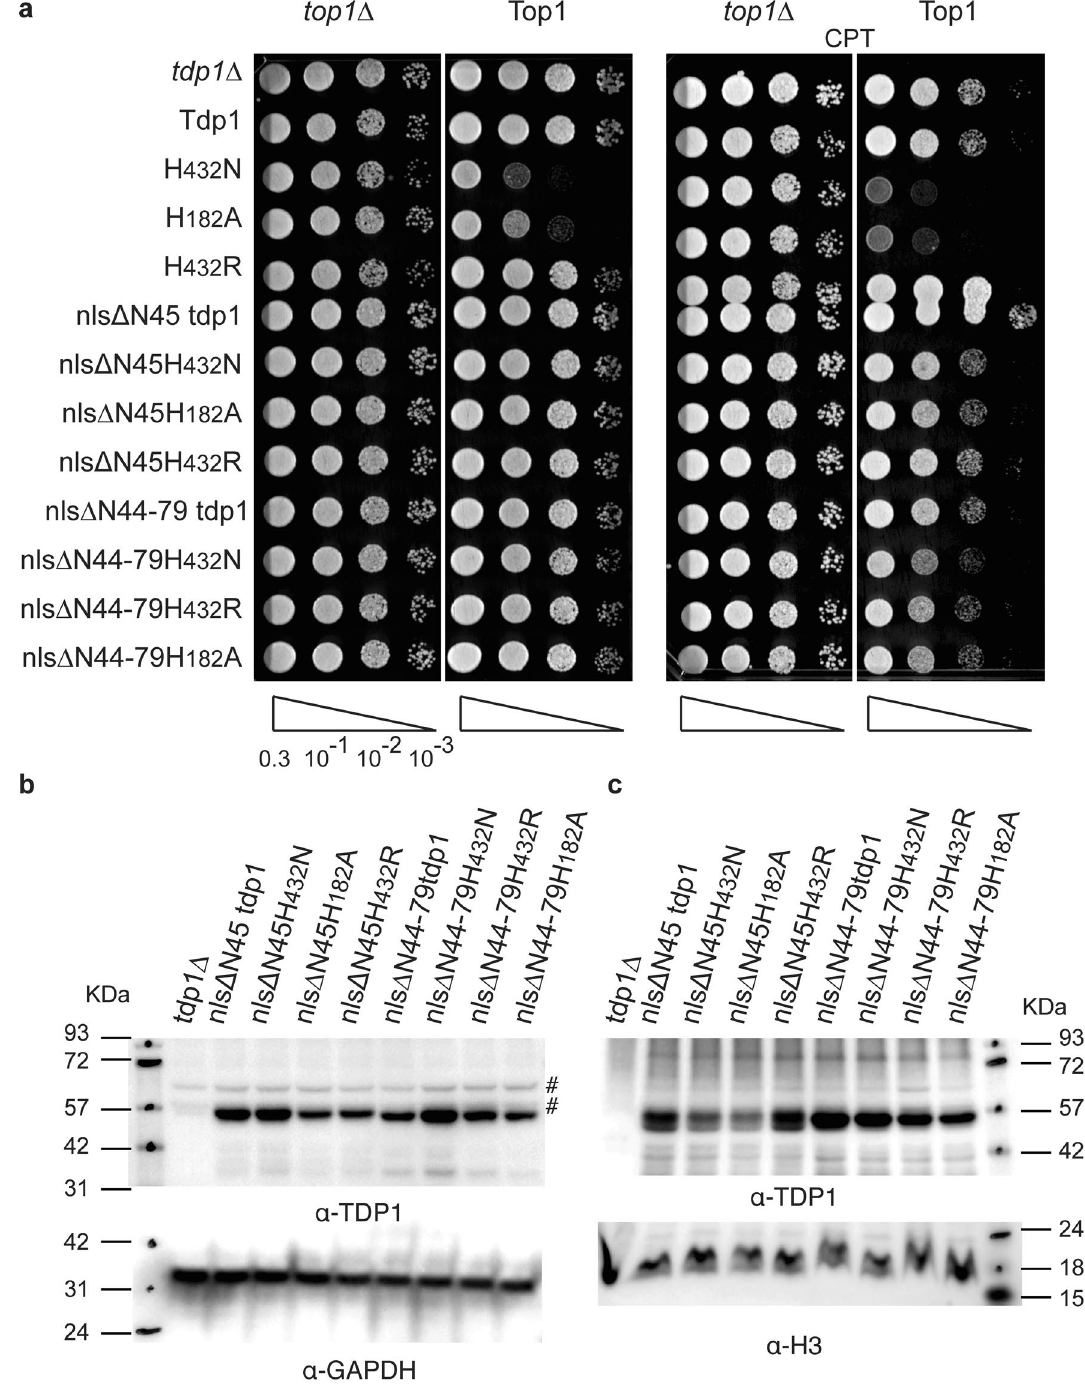
Figure 3. TDP1 in vivo catalysis of TOP1cc requires the complete NTD. ( a ) top1 Δ, tdp1 Δ cells were co-transformed with vector control ( top1 Δ) or YCpGAL1- TOP1 U (Top1) and control vector ( tdp1 Δ) or the indicated YCpGAL1- TDP1 L plasmid. Exponentially growing cultures were diluted to an OD 600 of 0.3 and three times ten-fold serially diluted (10 –1 , 10 –2 , 10 –3 , represented by triangle) and spotted onto selective galactose plates, with or without 5 μg/ml camptothecin (CPT). Plates were incubated at 30 °C for 4 days. ( b , c ) Ectopically expressed TDP1 protein levels in 20 μg/lane total cell extracts (b) or nuclear extracts ( c ) from galactose induced transformants used in (a-vector control) resolved on 10% SDS-PAGE and stained with anti-TDP1, stripped and stain with anti-GPDH (b) or anti-Histone H3 ( c ). FL: full-length TDP1; ΔN: N-terminal truncated TDP1 proteins. #: non-specific anti-Tdp1 antibody reactions; Molecular weight marker ladder in KDa. Shown are representative agar plates and immunoblots, cropped after adjustment of intensity of the whole membrane using photoshop. All images shown are from one membrane or agar plates (white box added for clear separation of the vector control ( tdp1 Δ) and Top1 expressing (Top1) spots) and are not merged products of different plates or membranes. Full membranes of immunoblots can be found in Fig.